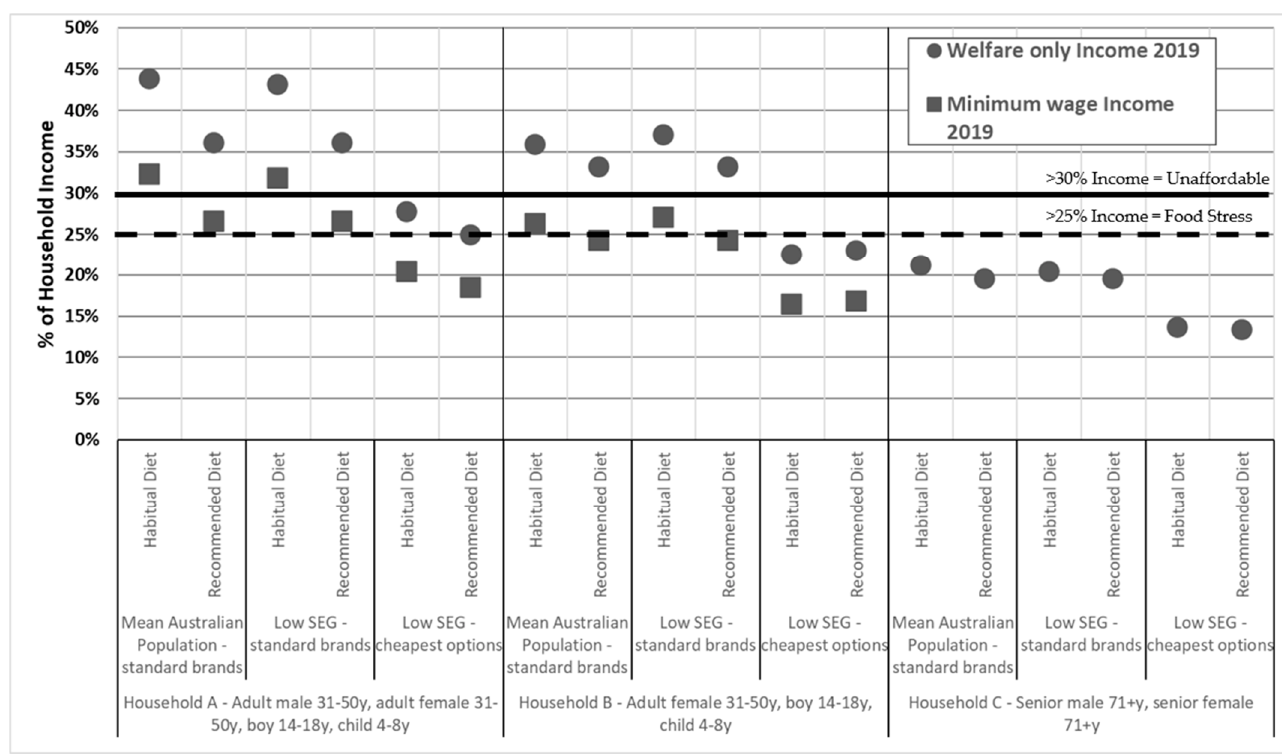
Figure 2. Affordability of habitual and recommended diets for mean population and low SEG reference households receiving welfare only and minimum wage incomes (using ‘standard brands’ and ‘cheapest options’). y = years.